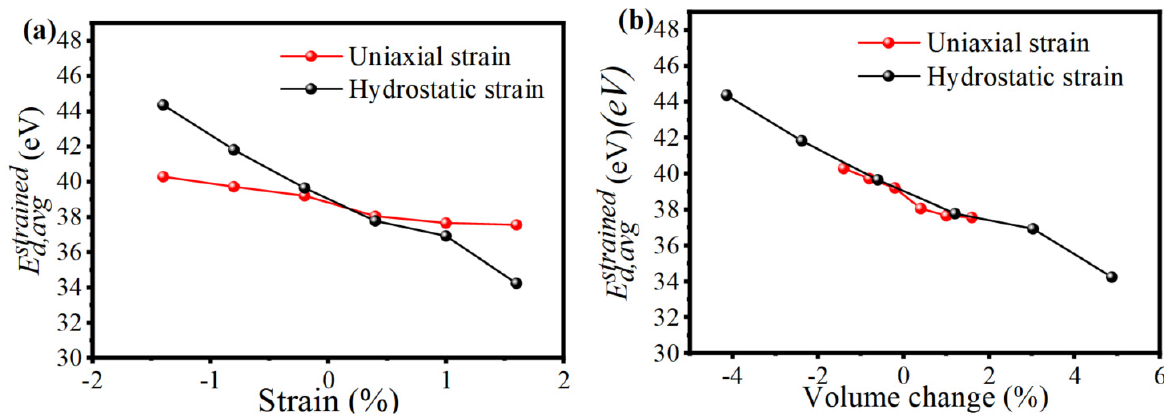
Figure 2. ( a ) Uniaxial and a hydrostatic correlation between 𝐸 (cid:3031),(cid:3028)(cid:3049)(cid:3034)(cid:3046)(cid:3047)(cid:3045)(cid:3028)(cid:3036)(cid:3041)(cid:3032)(cid:3031) and strain changes in α -Fe. ( b ) Correlation between uniaxial and hydrostatic strain changes for 𝐸 (cid:3031),(cid:3028)(cid:3049)(cid:3034)(cid:3046)(cid:3047)(cid:3045)(cid:3028)(cid:3036)(cid:3041)(cid:3032)(cid:3031) as volume change. Every single point is the average value of over 300 quasi-uniform directions.